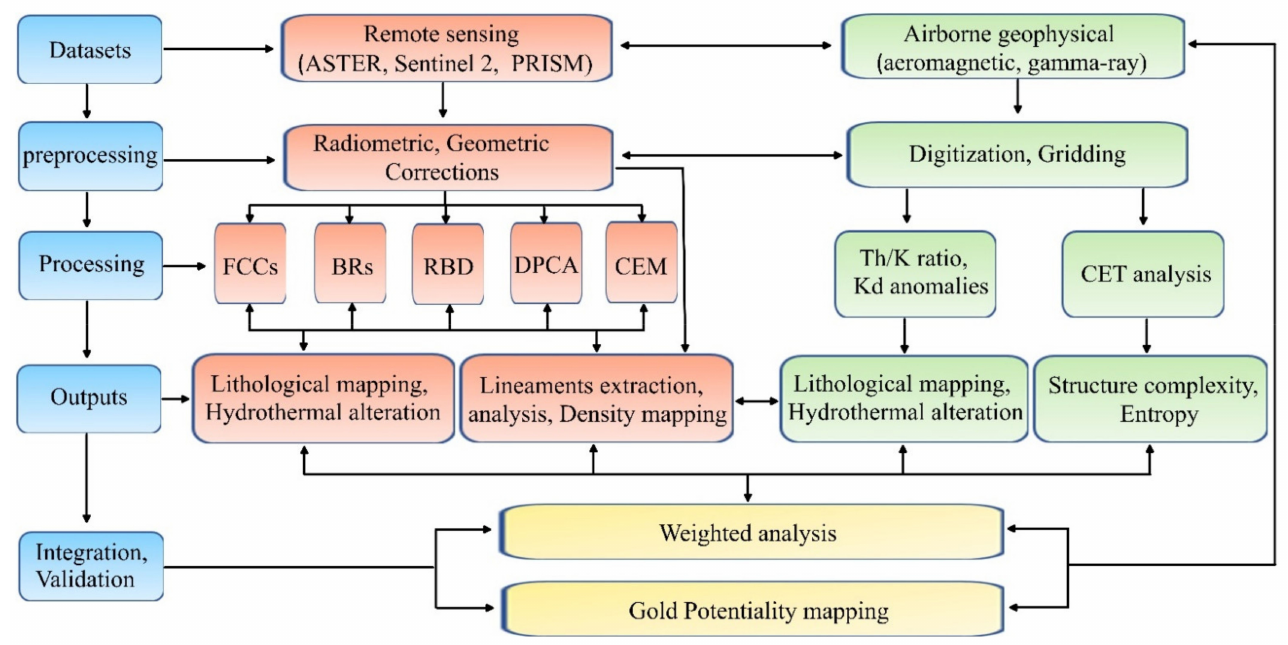
Figure 2. Flowchart methodology adopted in the current study.